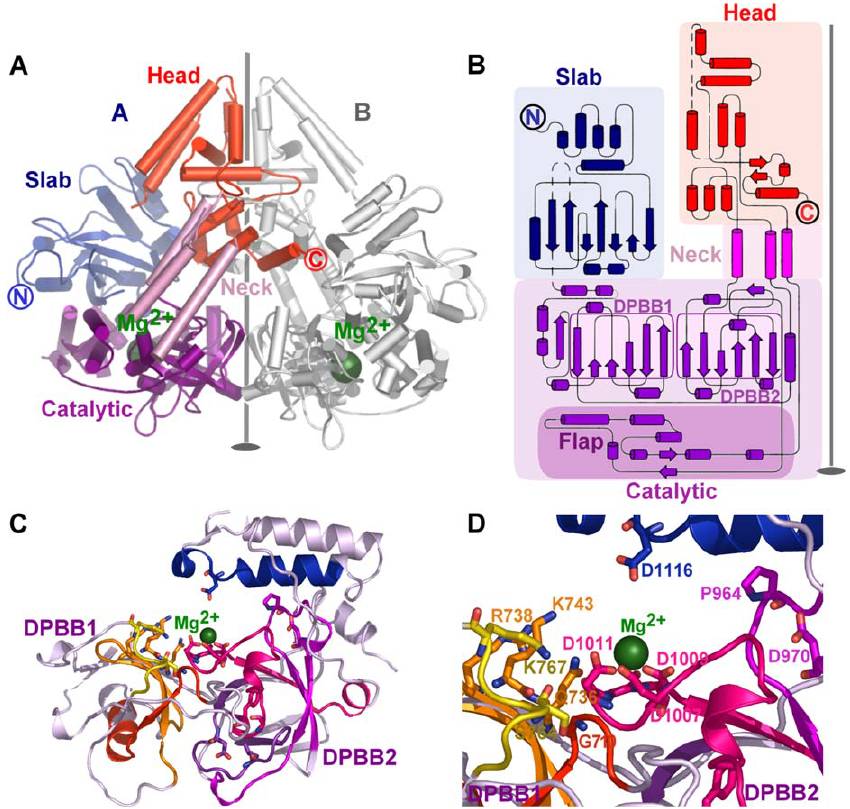
Figure 1. The Structure of QDE-1 D N (A) Cartoon representation of the QDE-1 D N P2 1 dimer–subunit A coloured according to domains: slab, blue; catalytic, purple; neck, pink; and head, orange; subunit B coloured grey. The approximate non-crystallographic 2-fold is represented as a grey line. Green spheres mark Mg 2 þ ions. Disordered regions correspond to ten residues at the N-terminus, 30 residues at the C-terminal, 45 residues in monomer A, and 48 in monomer B belonging to four loops (A: residues 590–603, 628–640, 1,241–1,251, and 1,271–1,281; B: 591–606, 627–640, 1,241–1,251, and 1,271–1,281). (B) Topology of QDE-1 D N subunit A, coloured as in (A). The catalytic subdomains DPBB1, DPBB2, and flap are denoted by boxes. The non- crystallographic 2-fold is represented as in (A). Disordered loops are represented by dashed lines. (C) View of presumed active site. The two DPBBs that form the active cleft, DPBB1 (residues 680–782) and DPBB2 (residues 916–1,018), are labelled. Sequence motifs conserved across other cRdRPs are highlighted: motif 1, red; 2, orange; 3, dark yellow, 4, purple; 5, dark pink; 6, bright pink; and 7, blue (see Figure S1). Invariant residues in cRdRPs are shown in ball-and-stick representation (O, red; and N, blue); Mg 2 þ ion shown as green sphere. (D) Zoom of active site region, with conserved residues labelled. Representation is as for (C). DOI: 10.1371/journal.pbio.0040434.g001